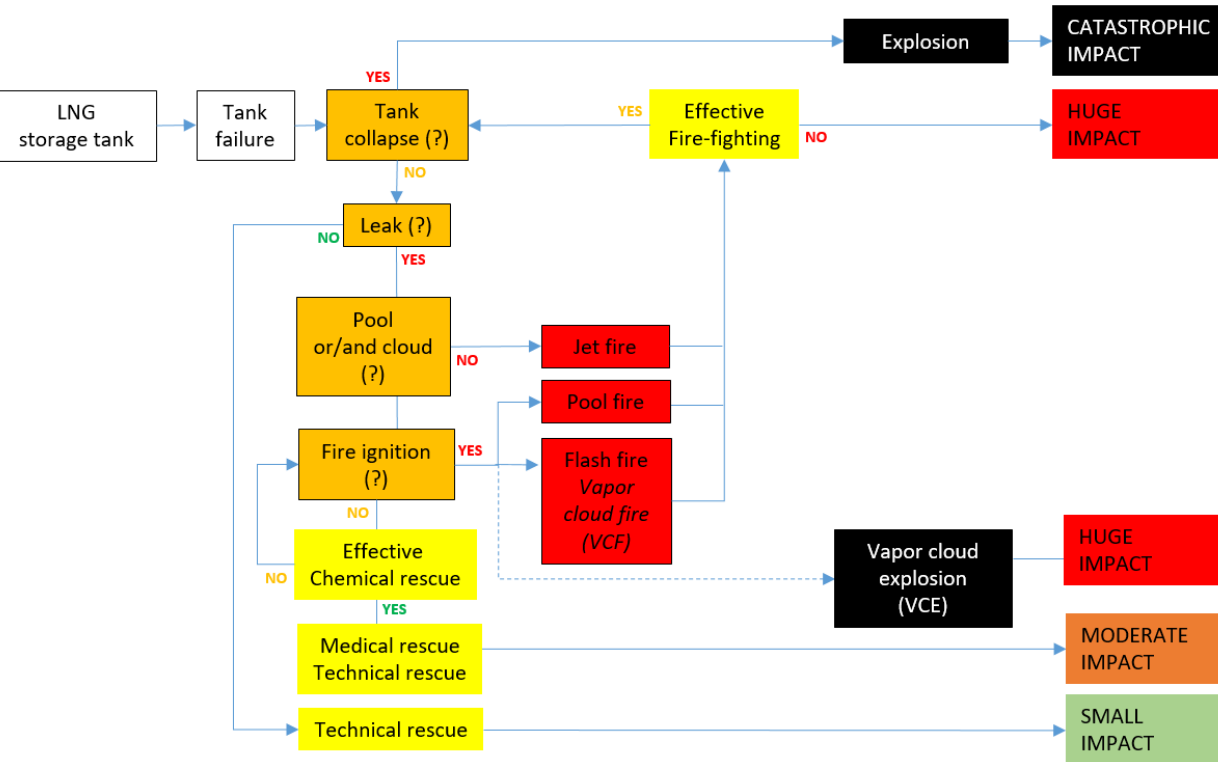
Figure 3. LNG conventional event tree for a pipeline. LNG conventional event trees are designed and shaped in order to be used for training and exercising purposes. Primarily, they can facilitate designing and creating